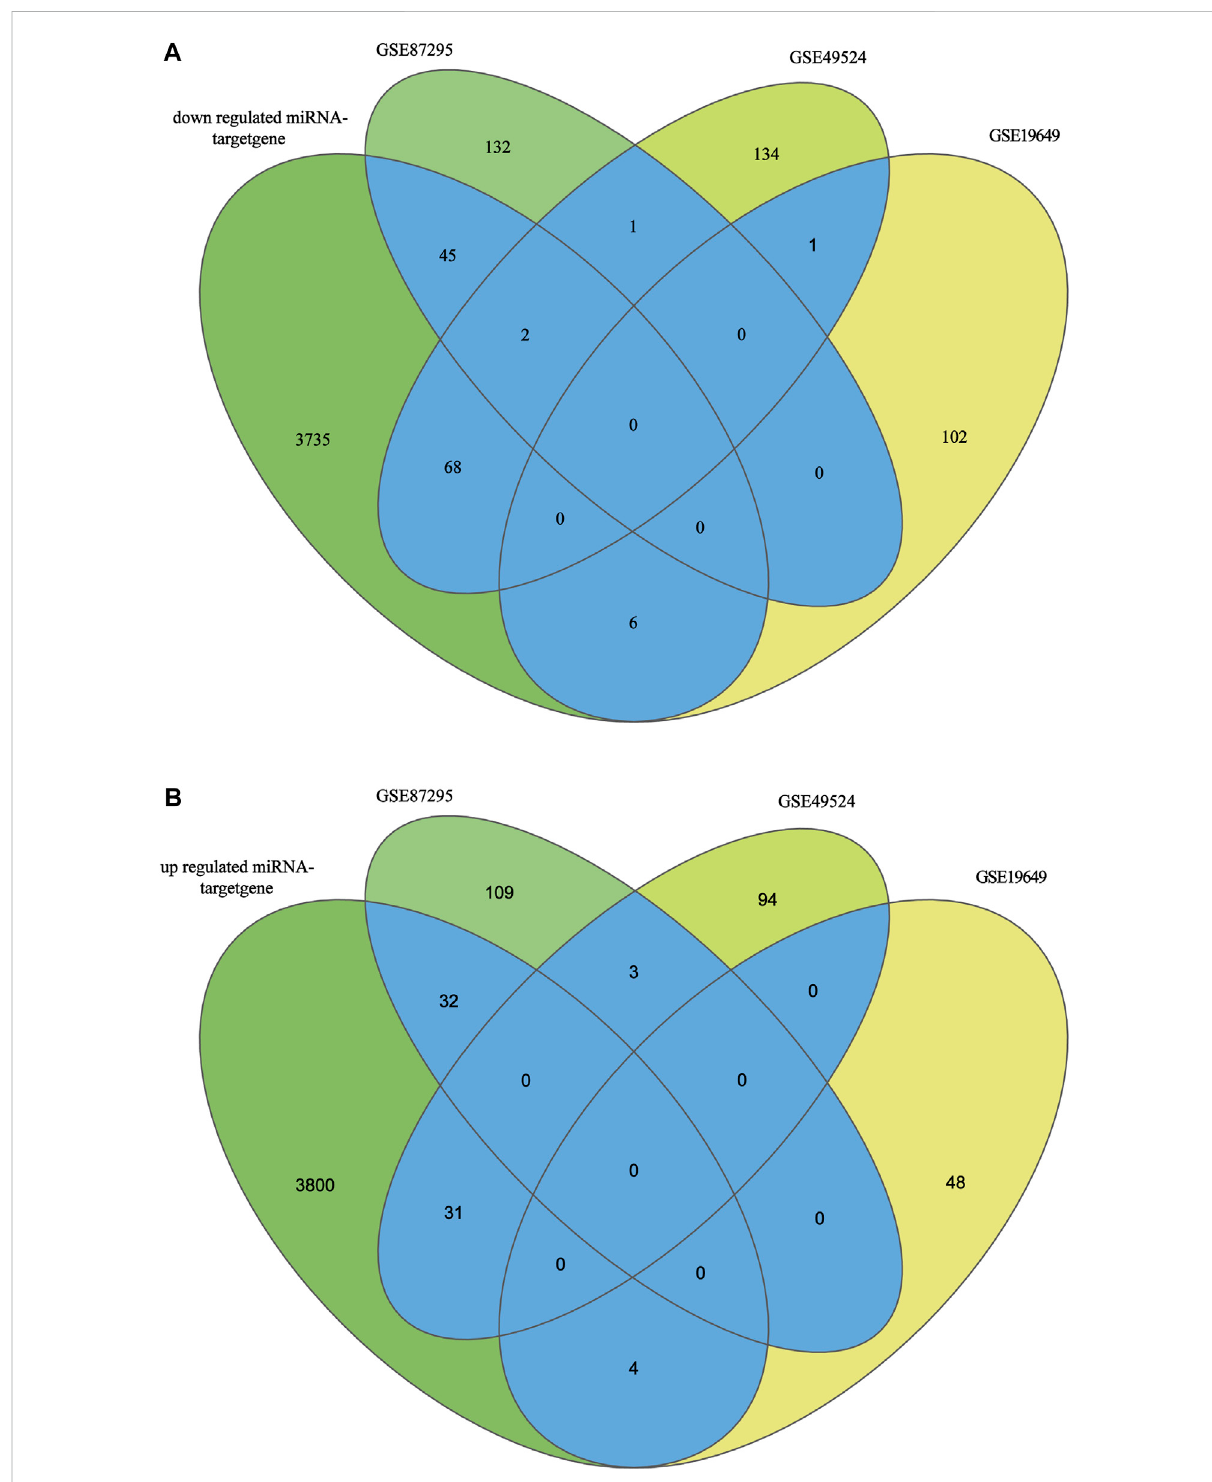
FIGURE 3 (A) : Target genes of low expression miRNAs and upregulated mRNAs of datasets. (B) : Target genes of high expression miRNAs and downregulated mRNAs of